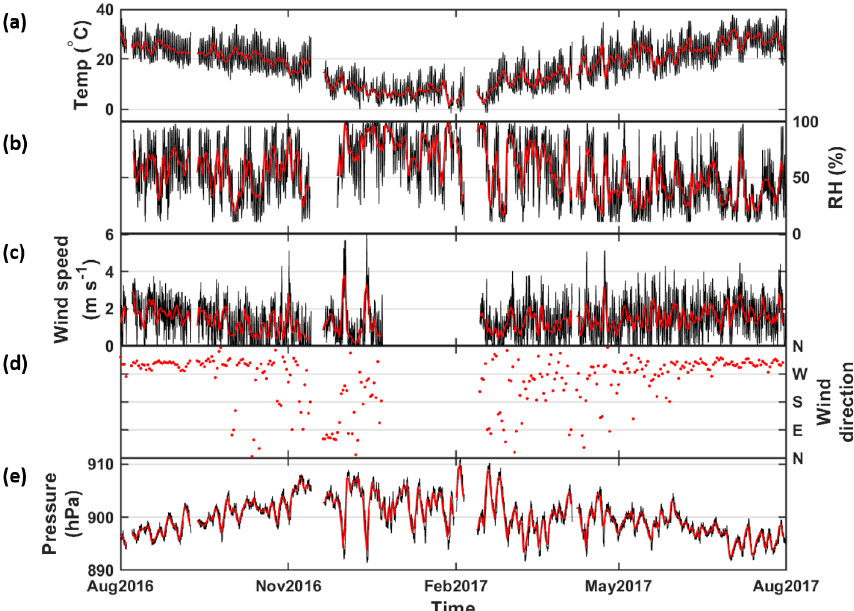
Figure 3. Time series of meteorological conditions during the measurement period August 2016–July 2017. (a–e) Temperature, relative humidity, wind speed, wind direction and air pressure, respectively. Black and red represent hourly and daily averaged data, respectively.